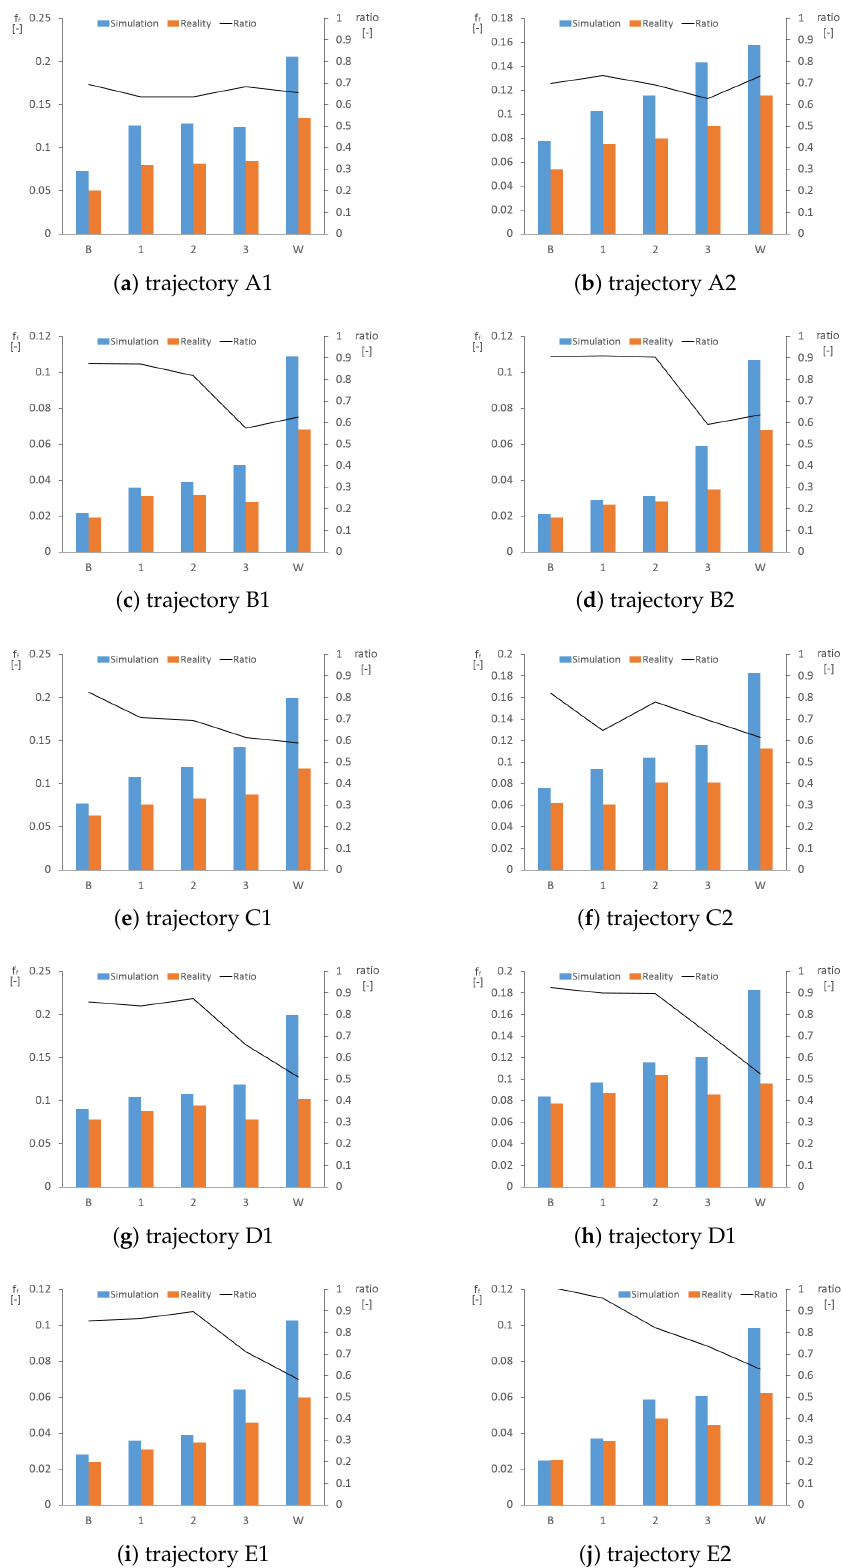
Figure 9. Comparison of the fitness function values acquired from simulation and experiments on the real robot; the black lines represent the ratio between the